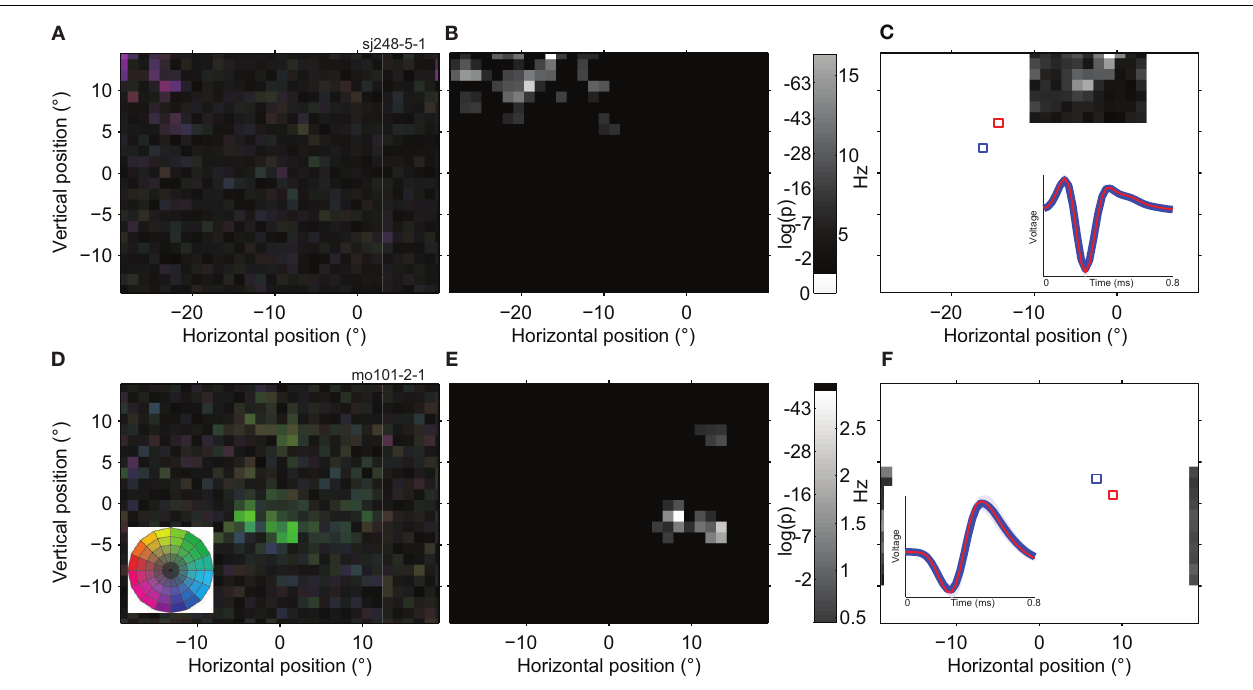
and blue outlined parts of the receptive field. Shading represents one standard deviation; in some places it is narrower than the line representing the average wave form.The red curve is deliberately thinner to make both, nearly identical, waveforms visible. (D) The receptive field of a second example neuron (20,592 spikes; 27min; L -ratio = 0.002).This neuron also has multiple sub-regions, and prefers a different direction of motion in the lower (green; up and to the right) than in the upper region (yellow; up and to the left). (E) Statistical analysis of the direction tuning of the neuron shown in (D) , same conventions as (B) . (F) Single dot response for the neuron shown in (D,E) , same conventions as (C ;The upper satellite of the RF was not mapped due to the restricted size of the GridRF stimulus).These examples show that individual, well-isolated MT neurons can have widely spread, multi-peaked receptive fields and that this substructure is independent of the stimulus used to map